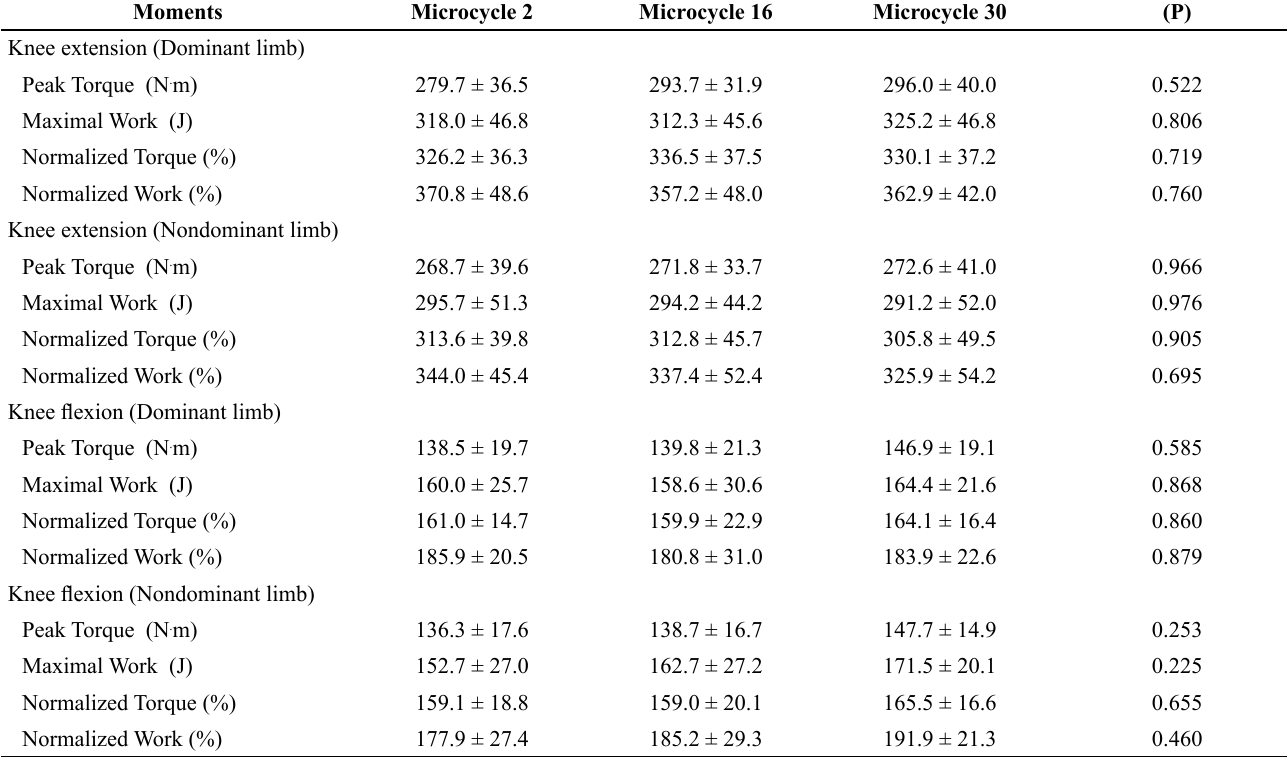
Table 4. Values of peak torque and maximal work of basketball players measured by isokinetic dynamometry at the speed of 60°/s during concen- tric contraction of knee flexor and extension in three different moments of macrocycle training.